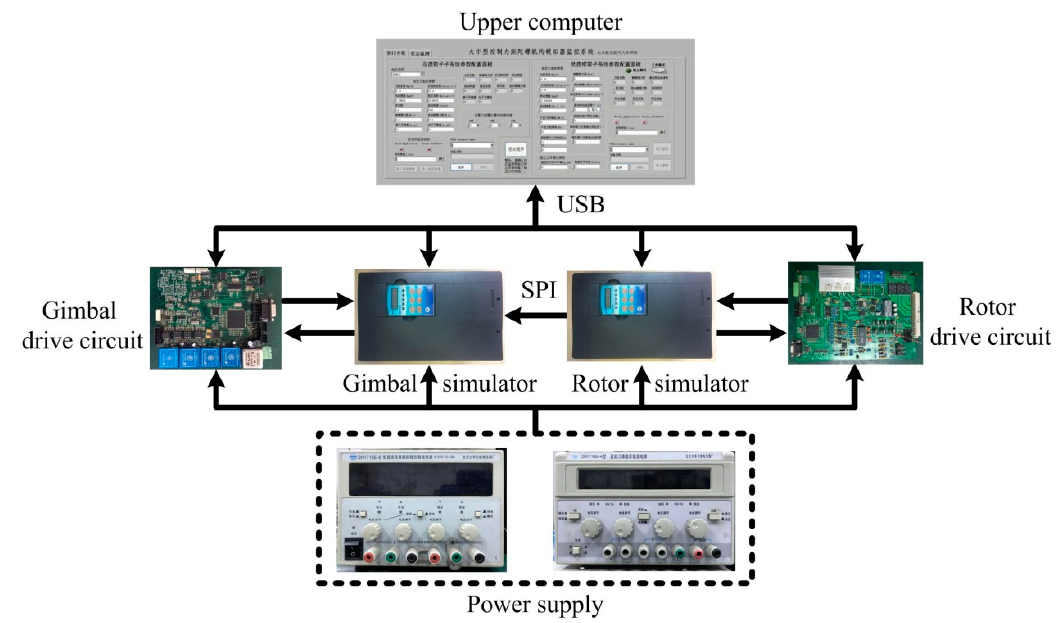
Figure 7. Structure of semi-physical experiment platform.